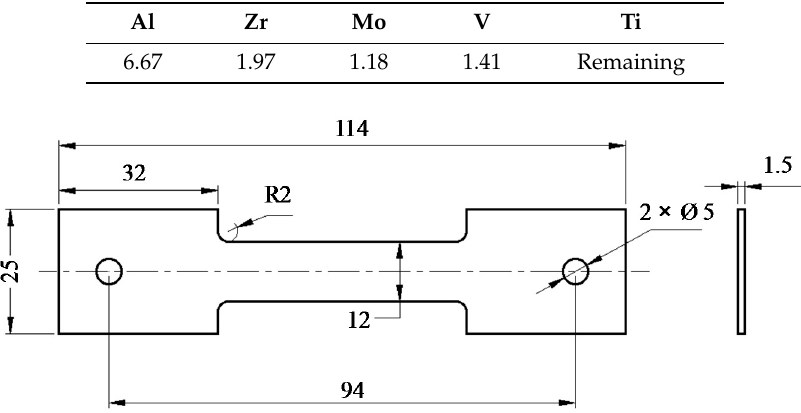
Figure 1. Initial microstructures of TA15 (light microscope). Table 1. The main chemical alloying elements of TA15 (wt %).